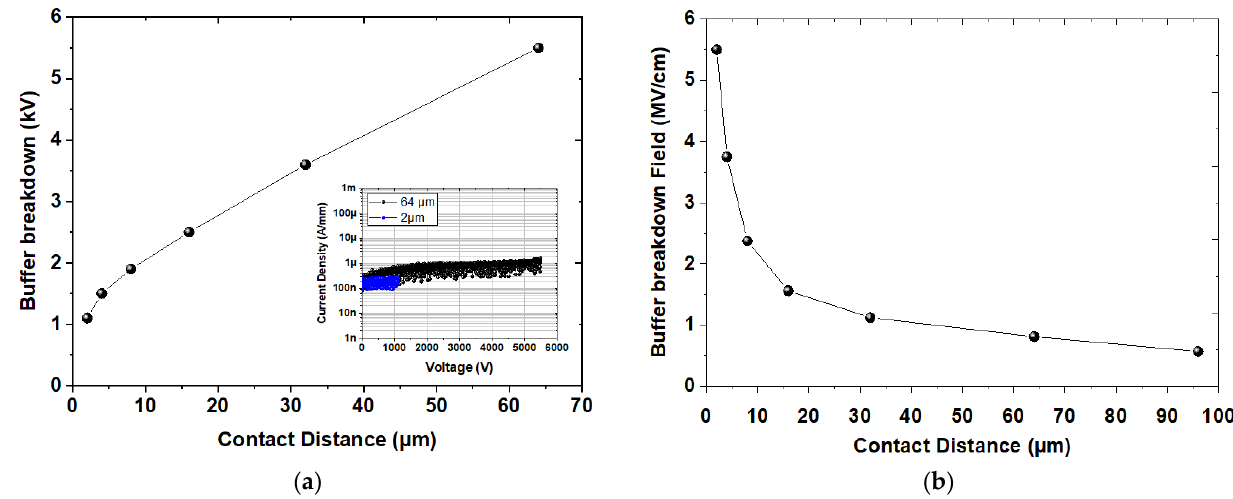
Figure 4. Buffer breakdown voltage (BV) ( a ) and related breakdown field ( b ) for various contact distances of AlN/AlGaN/AlN HEMTs.